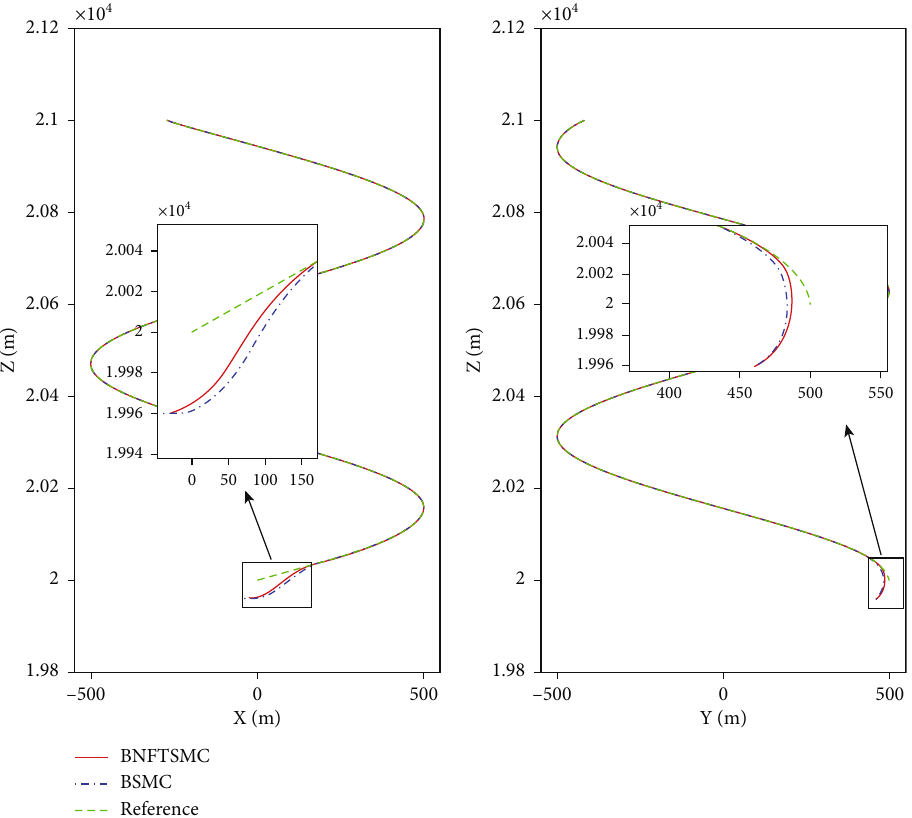
Figure 5: Projection of the trajectory tracking results on x - z plane and y - z